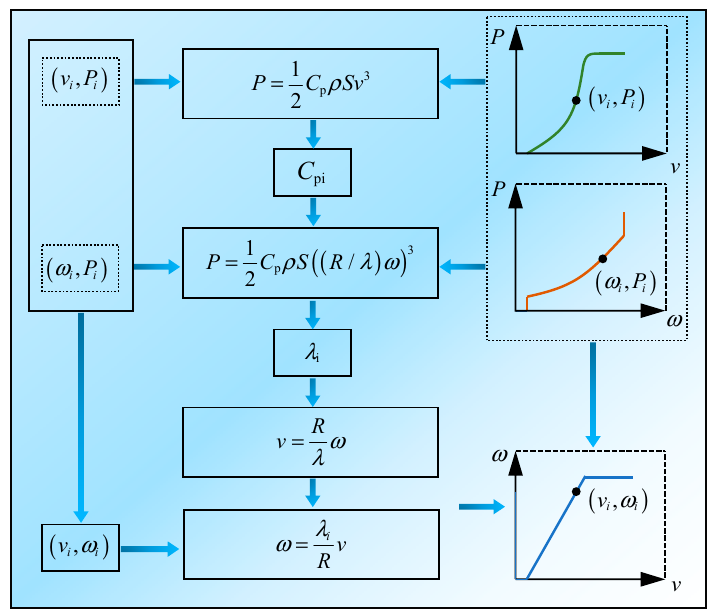
Figure 2. ECC of wind turbines.